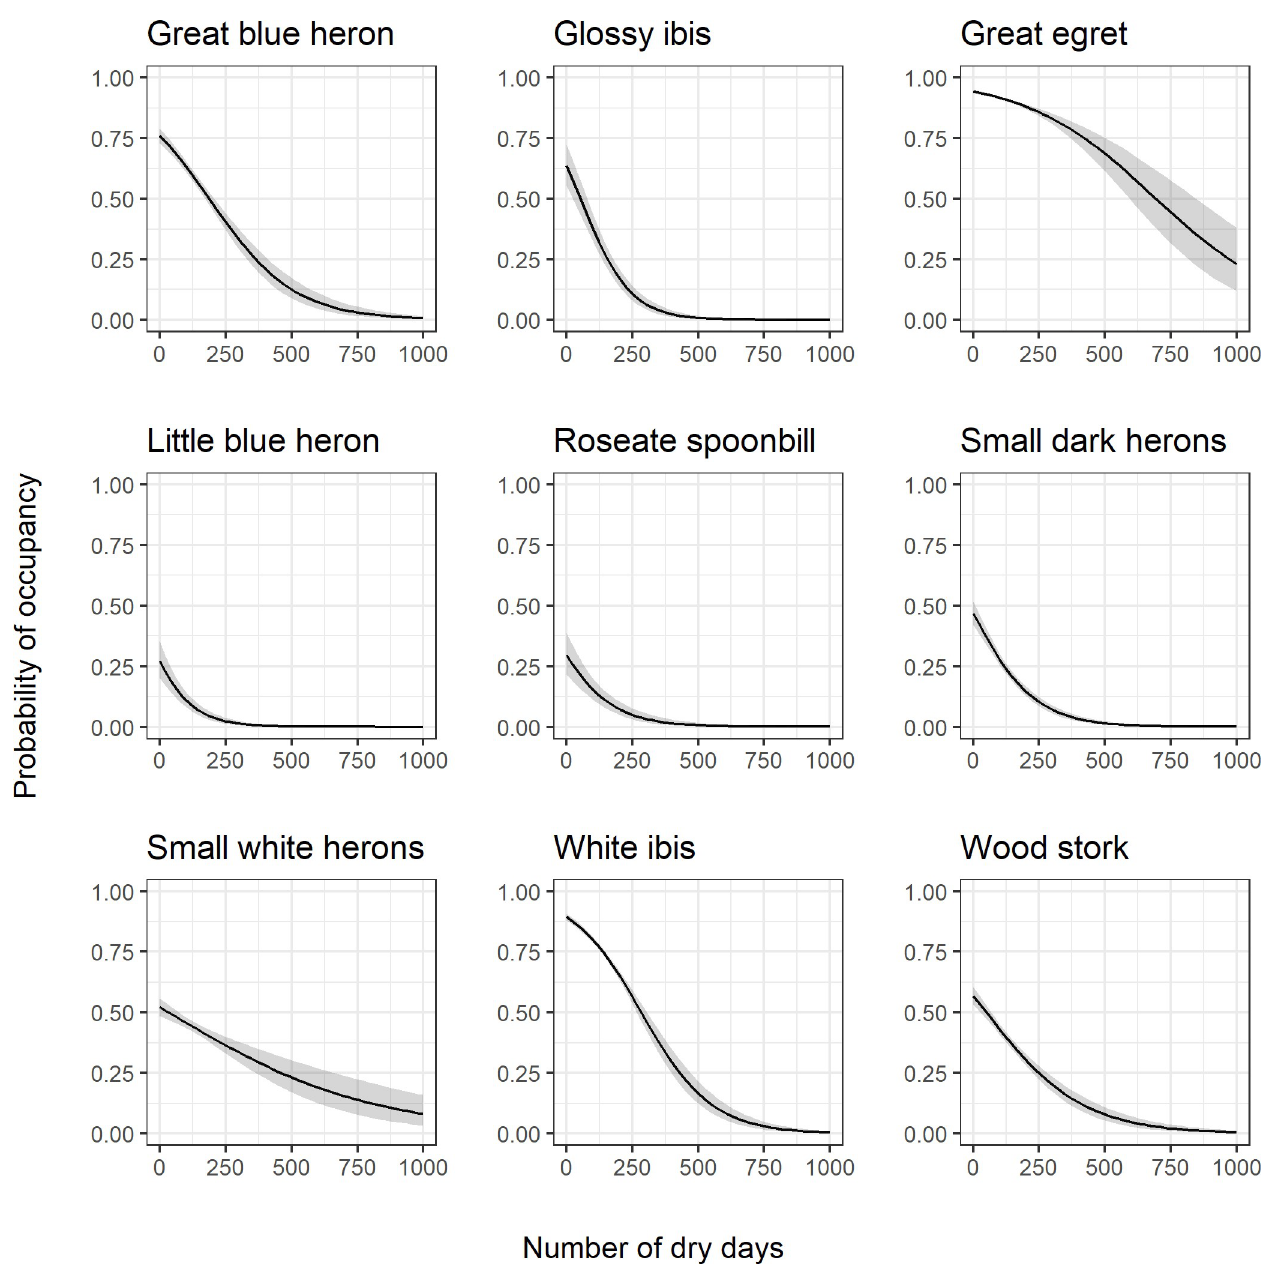
Fig 7. Number of dry days response curves. Species-specific relationships between probability of occupancy and number of dry days over the last 3 years from a fitted joint species distribution model of wading birds. Responses are calculated with all other model variables held at their mean. The black line represents the posterior mean and the gray shading represents the 95% posterior